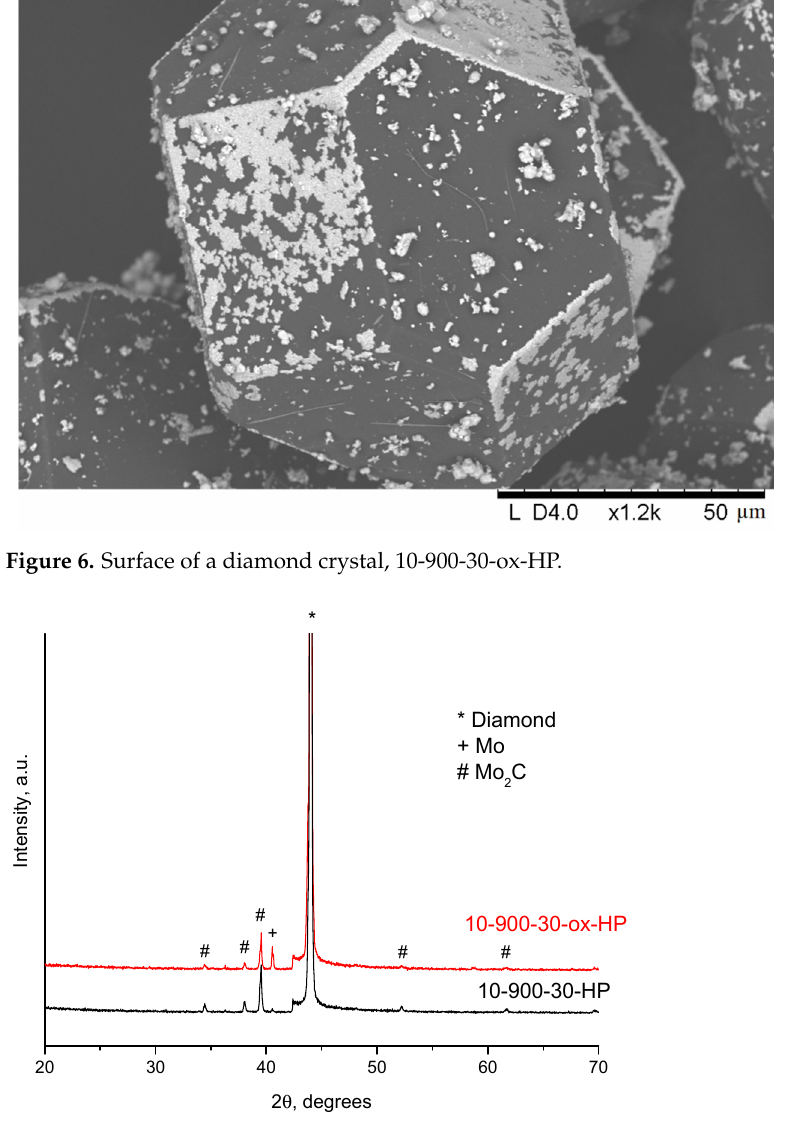
Figure 7. XRD patterns of the samples obtained at 900 °C, treatment for 30 min, with use of Mo and Mo(ox) as a metal source.